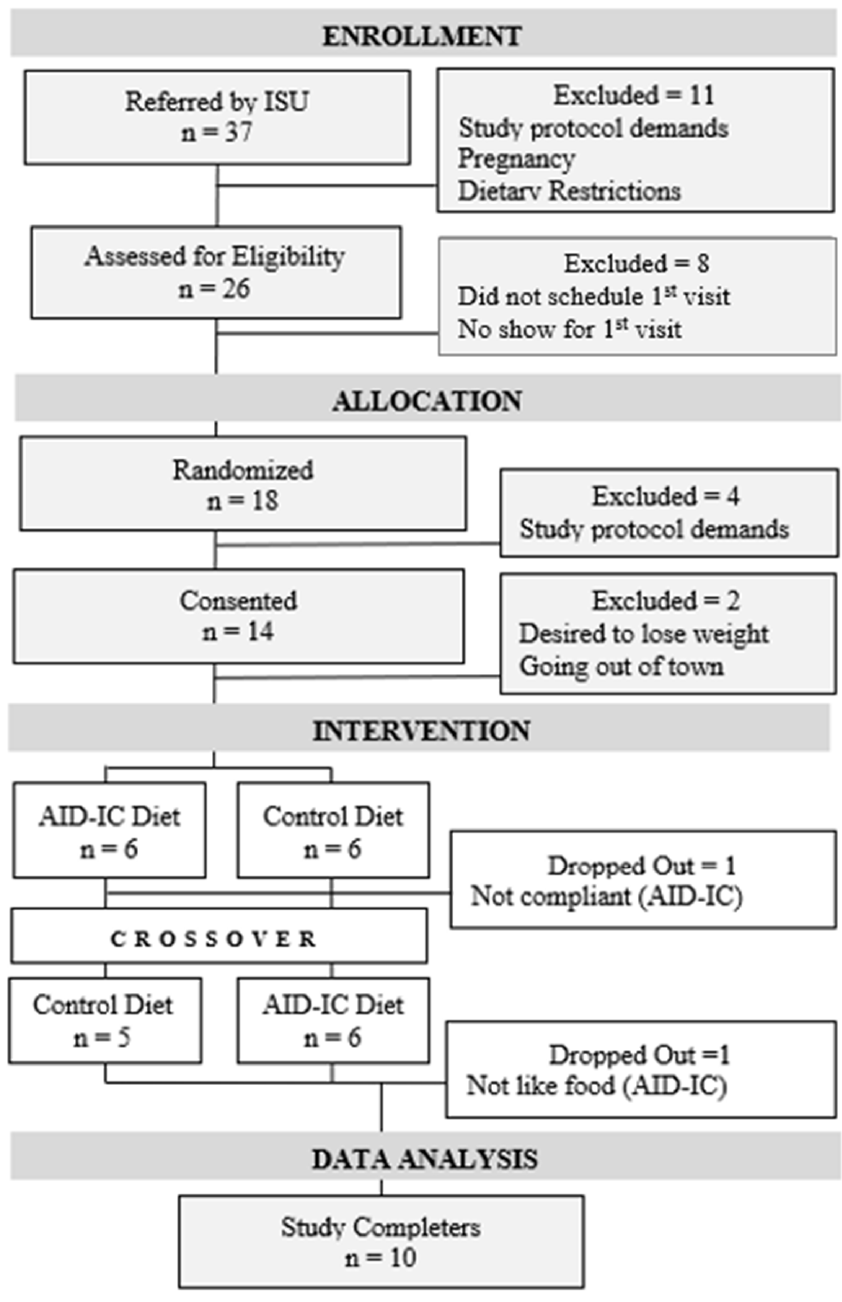
Figure 1. Participant flow chart (CONSORT).